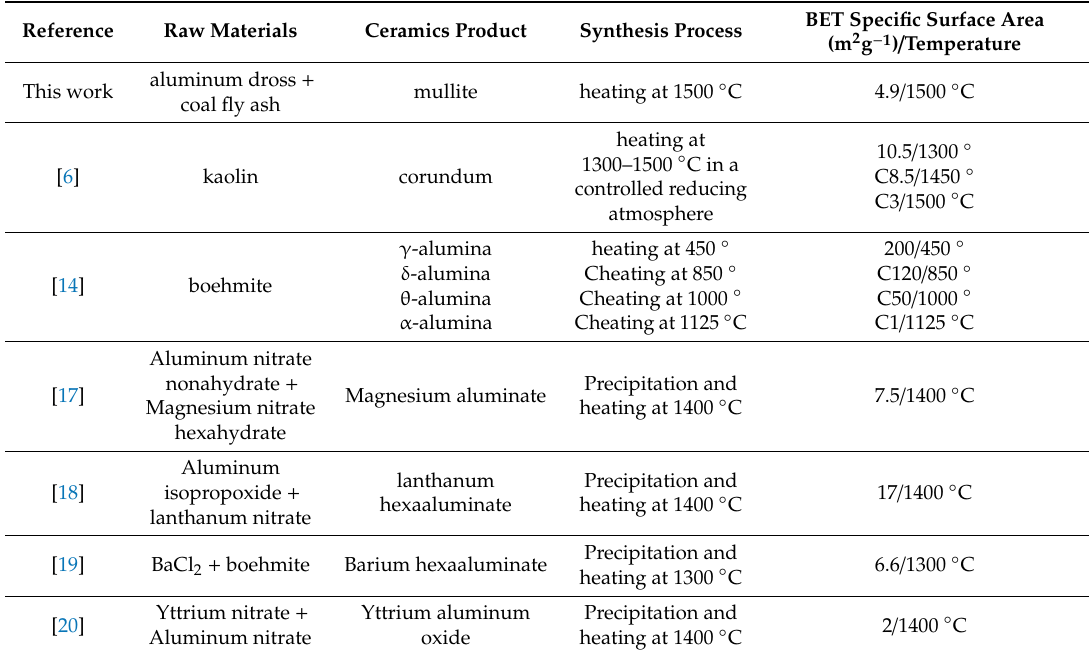
Figure 8. Barrett–Joyner–Halenda (BJH) cumulative pore size distribution (logarithmic scale on the x-axis) of washcoat synthesized using aluminum dross and coal fly ash . Table 3. Comparison of the Brunauer–Emmer-Teller (BET) specific surface area between the present mullite washcoat and other existing washcoats produced from di ff erent raw